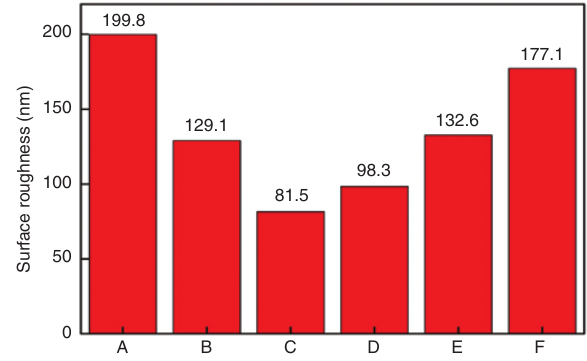
Figure 9: Surface roughness of diamond film samples obtained at various gas flow rates (sccm). (A) O O -1, Ar-14; (D) O 2